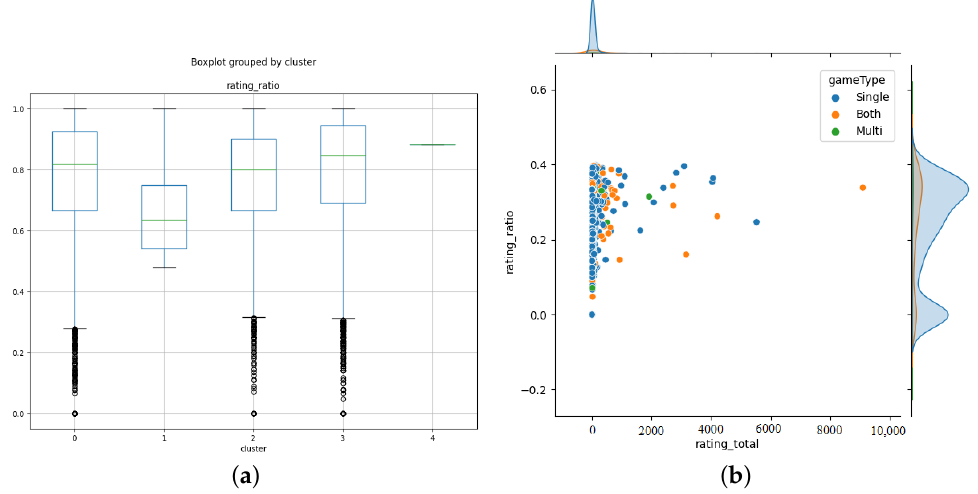
Figure 12. The positive rating ratio provided by ( a ) clusters (Boxplot of positive rating ratio grouped by game clusters) and ( b ) against the total ratings (Scatter plot of positive rating ratio against total rating based on game